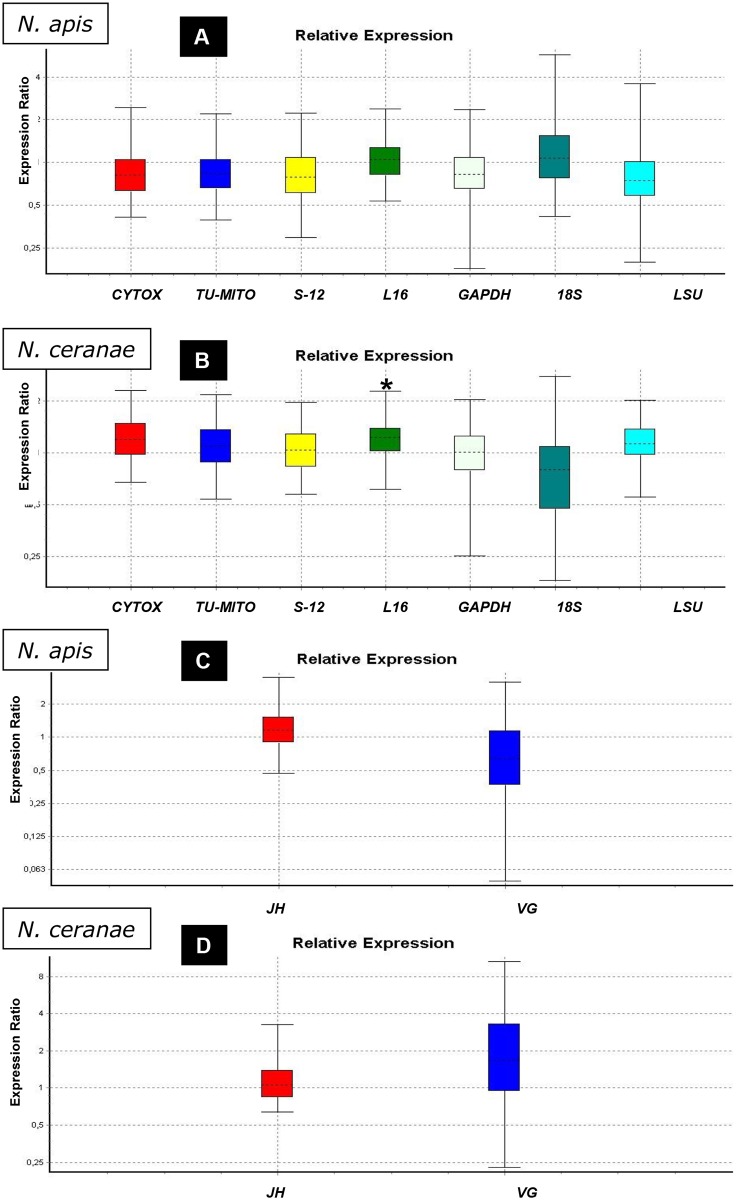
Relative expression ratio plots for genes related to mitochondrial and hormone activity.Analysis of groups infected with N. apis or N. ceranae relative to the uninfected bees. (*) significant differences. A) Mitochondrial activity in N. apis infected bees. B) Mitochondrial activity in N. ceranae infected bees. The expression for GAPDH and 18S (not used as housekeeping genes) is also represented here. C) Hormone activity in N. apis infected bees. D) Hormone activity in N. ceranae infected bees.